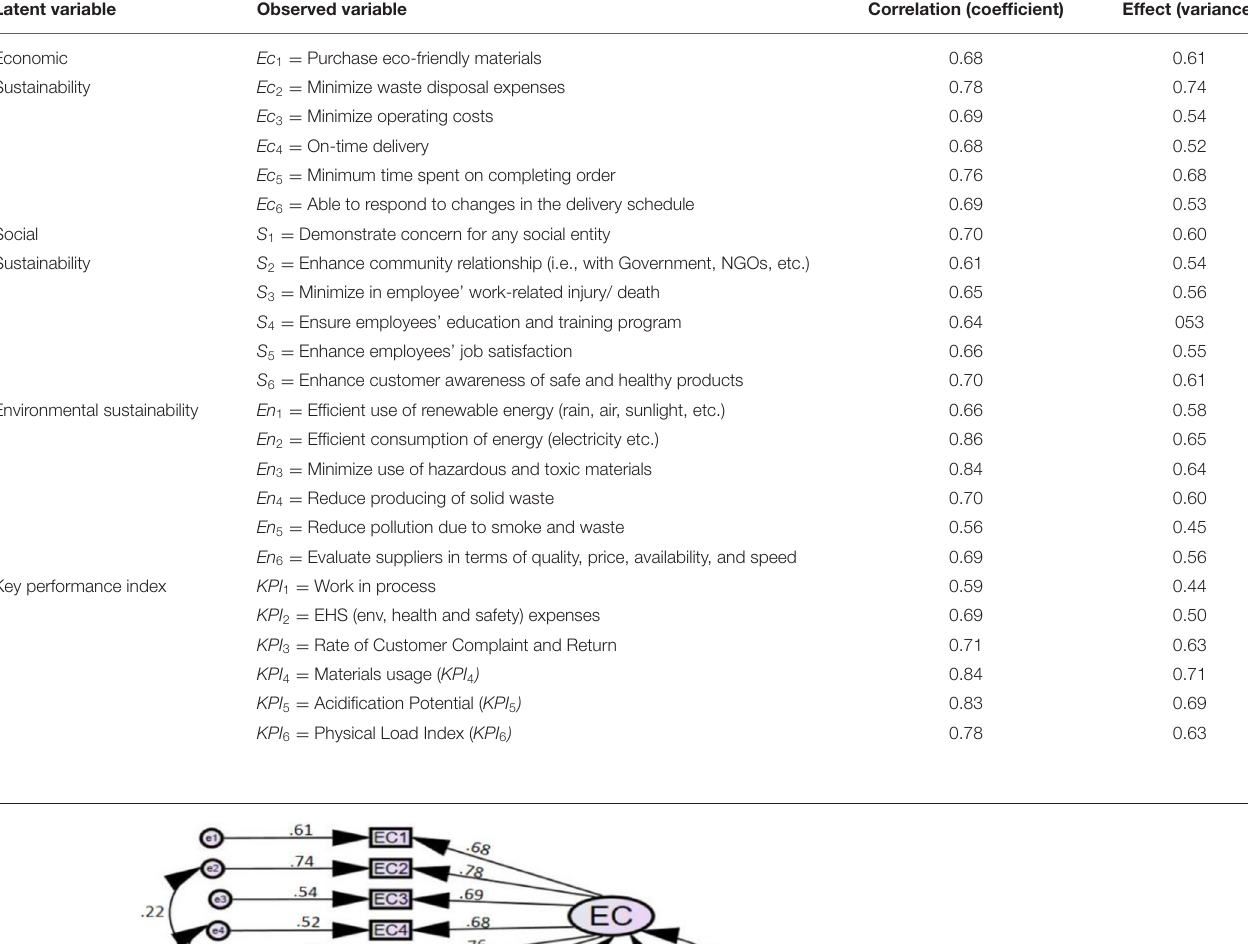
TABLE 12 | Output summary of the confirmatory factor analysis (CFA).